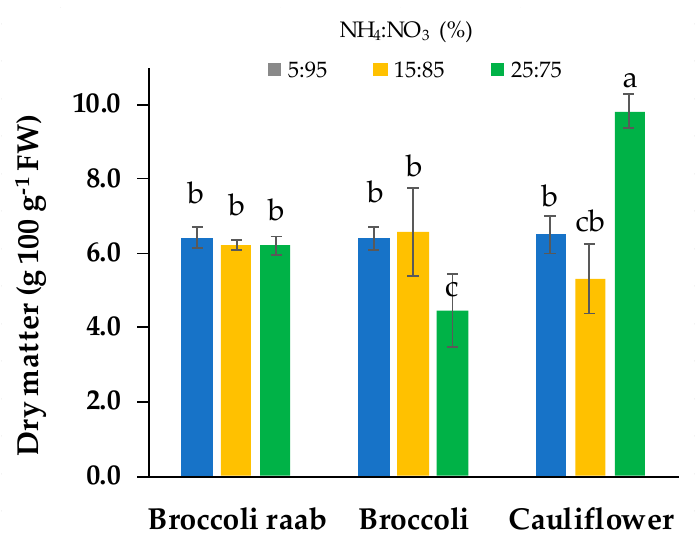
Figure 5. Dry matter content of three genotypes of microgreens grown by using a NS with three different NH 4+ :NO 3 − (%) molar ratios: 5:95, 15:85 and 25:75. Different letters indicate that mean values are significantly different, according to the SNK test ( p = 0.05). Vertical bars represent ± standard deviation of mean values.